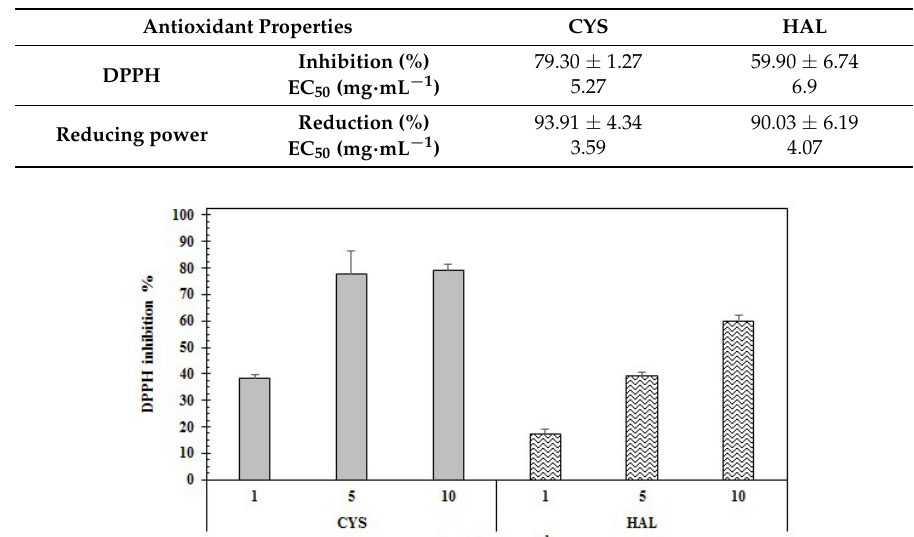
Table 1. Antioxidant properties of CYS and HAL aqueous extracts.